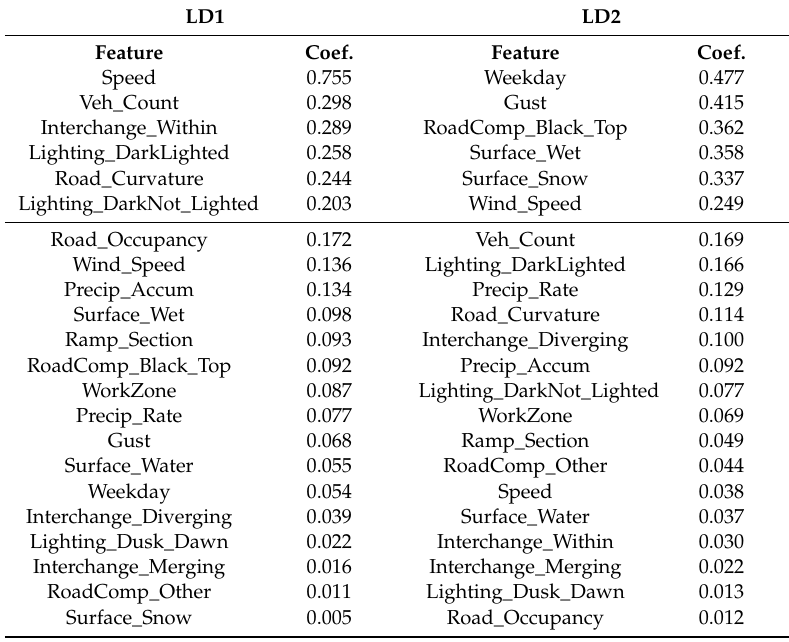
Table 5. Loading factors for RTWE features.